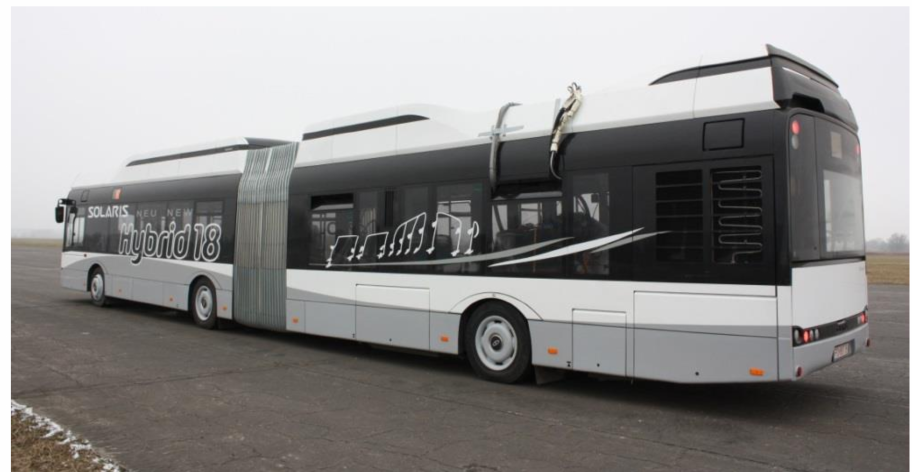
Figure 4. The Solaris Urbino 18 Hybrid bus with the exhaust gas sampling system.